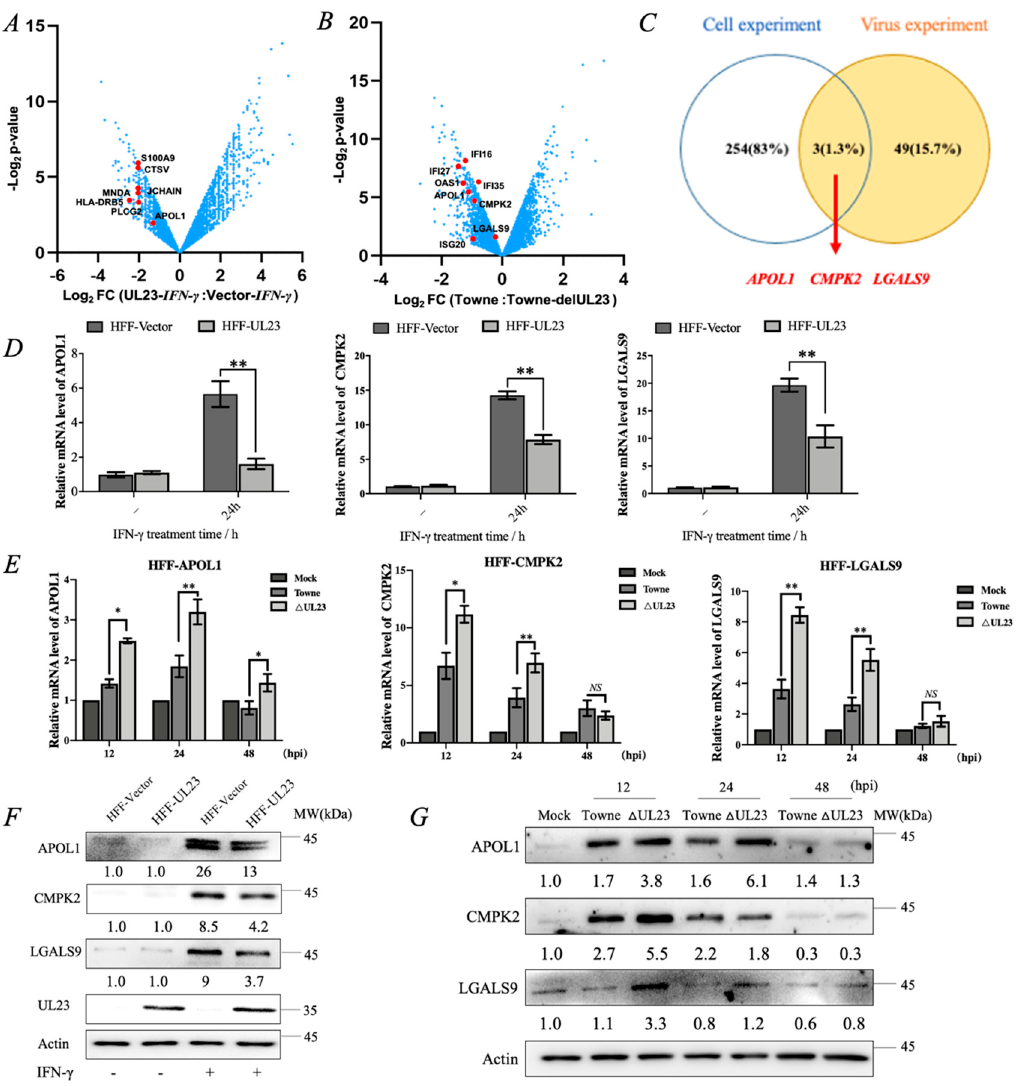
Figure 1. HCMV-encoded protein UL23 inhibits the expression of IFN-inducible genes Apol1, Cmpk2, and Lgals9. ( A ) UL23 stably expressed HFF cells (HFF-UL23) and control cells (HFF-Vec) were treated with 1000 U/mL IFN- γ for 24 h. Volcanic map showing expression of cellular targets of UL23 in HFF cells after stimulation by IFN- γ . ( B ) HFF cells infected with HCMV-Towne or HCMV-Towne- ∆ UL23 (MOI = 1) for 24 h. Volcanic map showing the effects of UL23 on host gene expression after HCMV infection of HFF cells. ( C ) Boolean operation analysis showed that HCMV-Towne vs. HCMV-Towne- ∆ UL23 differentially expressed genes and Vec-IFN- γ vs. UL23-IFN- γ differentially expressed genes were composed of APOL1, CMPK2, and LGALS9. ( D ) The effects of ectopic expression of UL23 on the gene expression of APOL1, CMPK2, and LGALS9 with or without IFN- γ (1000 U/mL) stimulation. ( E ) HCMV or HCMV- ∆ UL23 (MOI = 1) was used to infect HFF cells for different time points. The APOL1, CMPK2, and LGALS9 mRNA expressions were measured through RT-qPCR, with GAPDH as the reference. ( F ) HFF-UL23 and HFF-Vector cells were treated with IFN- γ (1000 U/mL) for 24 h before Western blotting. ( G ) HCMV-Towne or HCMV-Towne- ∆ UL23 (MOI = 1) was used to infect HFF cells for different time points, and total cell lysates were analyzed by immunoblot using the indicated antibodies. Each assay was conducted thrice. Data are shown as mean ± SD. * p < 0.05, ** p < 0.01, NS denotes not significant ( p > 0.05). Data are representative of three independent experiments with similar